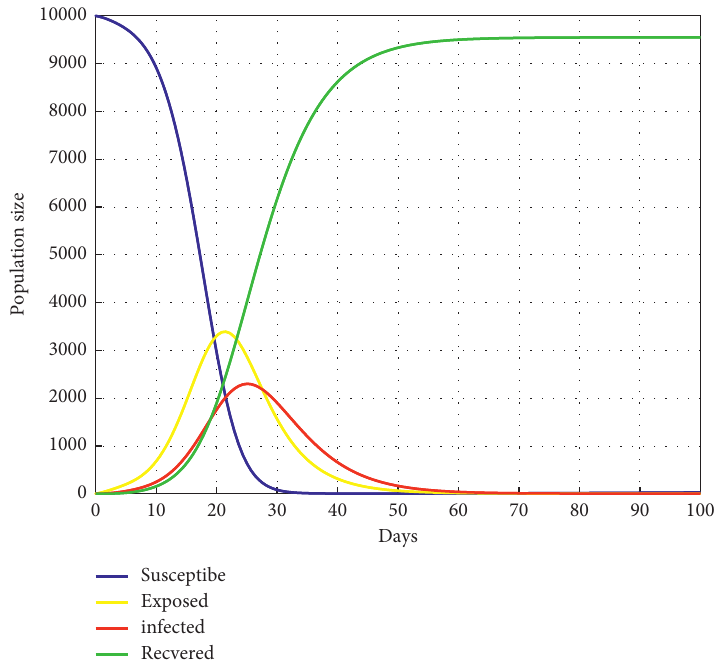
Figure 5: Evolution of the epidemic spreading considering the full